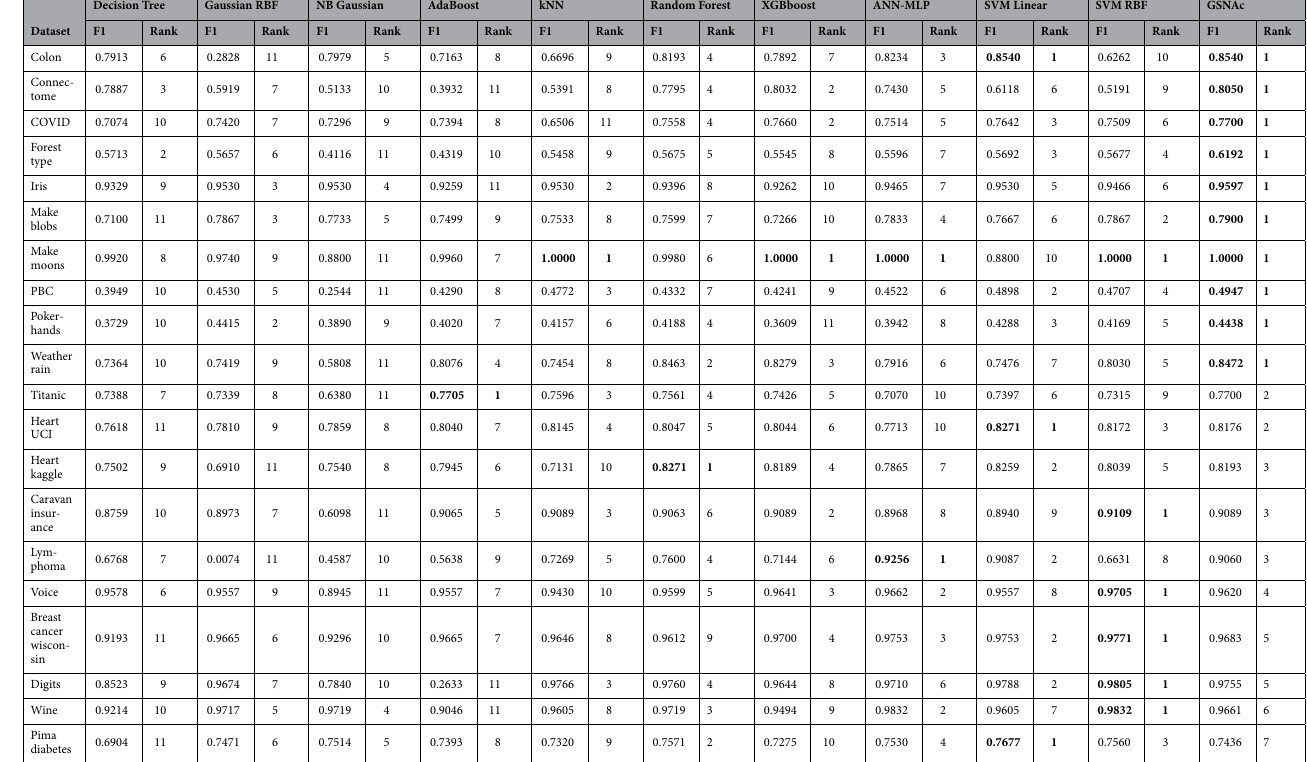
Table 3. Performance comparison of GSNAc with other classifiers. F1 stands for F1 weighted score. The bold values indicates the top score and rank for the respective dataset. Rows are sorted by GSNAc Models’ success, columns (classifiers) are sorted by their respective cumulative successes.